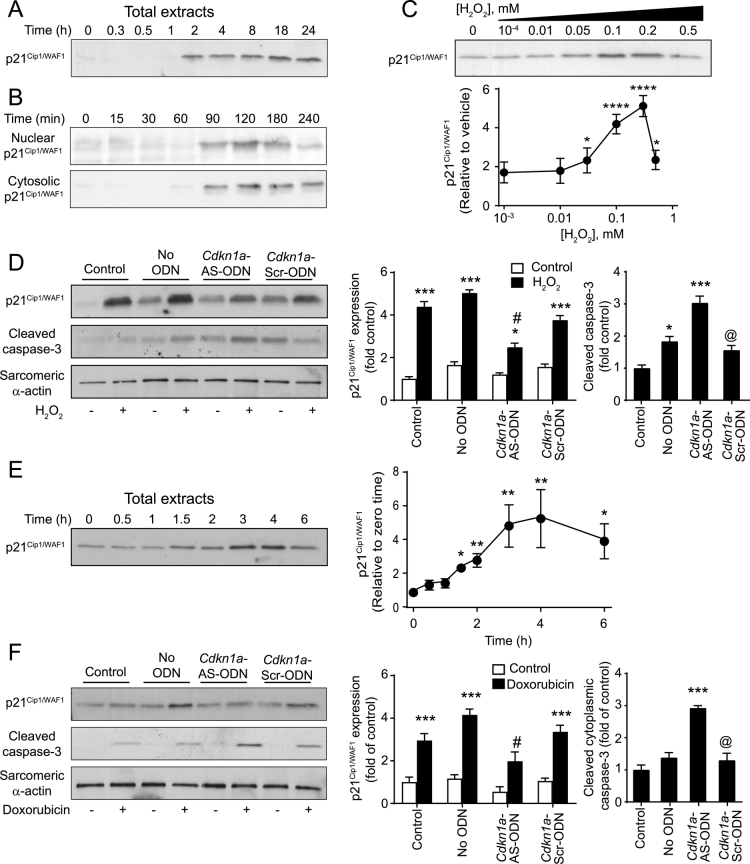
H2O2 or doxorubicin increase p21Cip1/WAF1 protein in cardiomyocytes to reduce apoptosis. (A) and (B) Cardiomyocytes were exposed to 0.2 mM H2O2 [(A) and (B)] or to 0.4 mM doxorubicin (E) for the times indicated and total extracts [(A) and (D)] or nuclear and cytosolic extracts (B) immunoblotted with antibodies to p21Cip1/WAF1. Representative immunoblots of at least 4 independent experiments are shown. Densitometric analysis is included to the right panels (A) and (D). Results are means ± SEM (n = 4 independent myocyte preparations). *p < .05, **p < .01 relative to unstimulated cells (one-way ANOVA with Dunnett's post-test). (C) Cardiomyocytes were exposed to the concentrations of H2O2 indicated for 120 min and immunoblotted with antibodies to to p21Cip1/WAF1. Densitometric analysis is included below the panel. Results are means ± SEM (n = 4 independent myocyte preparations). *p < .05, ****p < .0001 relative to unstimulated cells (one-way ANOVA with Dunnett's post-test). (D) and (F), Cardiomyocytes were exposed to 0.2 mM H2O2 (4 h) or 0.4 mM doxorubicin (4 h) alone (Control), following treatment with transfection reagent without oligodeoxynucleotides (no ODN) or following transfection with antisense ODNs (AS-ODNs) for Cdkn1a or scrambled ODNs (Scr-ODNs). Samples were immunoblotted with antibodies to p21Cip1/WAF1, cleaved caspase 3 or the loading control sarcomeric α-actin. Representative immunoblots are shown on the left, with densitometric analysis on the right. Data are means ± SEM (n = 6 independent myocyte preparations). *p < .05, ****p < .0001 relative to vehicle, #p < .01 relative to H2O2 treated cells with no ODNs, @ p < .05 relative to Cdkn1a-AS-ODN (two-way ANOVA with Tukey post-test).